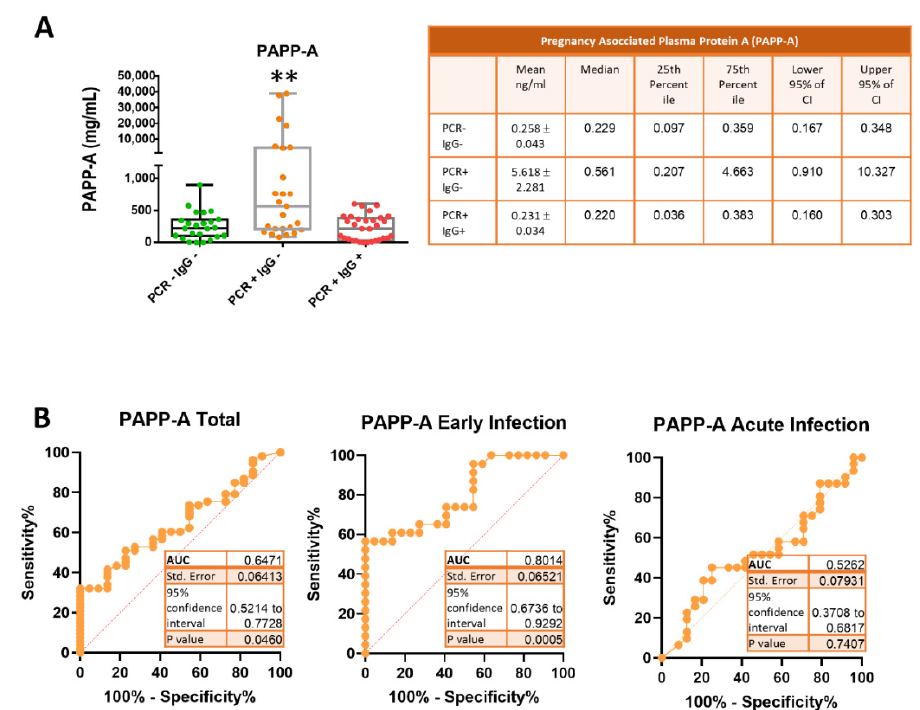
Figure 3. Levels of pregnancy-associated plasma protein-A (PAPP-A) in the sera of COVID-19 pa- tients. ( A ) Boxand -whisker plots of PAPP-A concentrations in patient samples. PCR − IgG − , patients with a discharge diagnosis of COVID-19 (green); PCR+ IgG − , patients with early SARS-CoV-2 infection (orange); PCR+ IgG+, patients with active SARS-CoV-2 infection (red). Data in the graph represent the mean ± S.D. ** p ≤ 0.01. The right table shows the mean ± standard error, the median, 25th percentile, 75th percentile, lower 95% of CI and upper 95% of CI of PAPP-A values. ( B ) Receiver operating characteristic (ROC) curves and area under the curve (AUC) for pregnancy-associated plasma protein-A in SARS-CoV-2-infected patients (total, early infection and acute